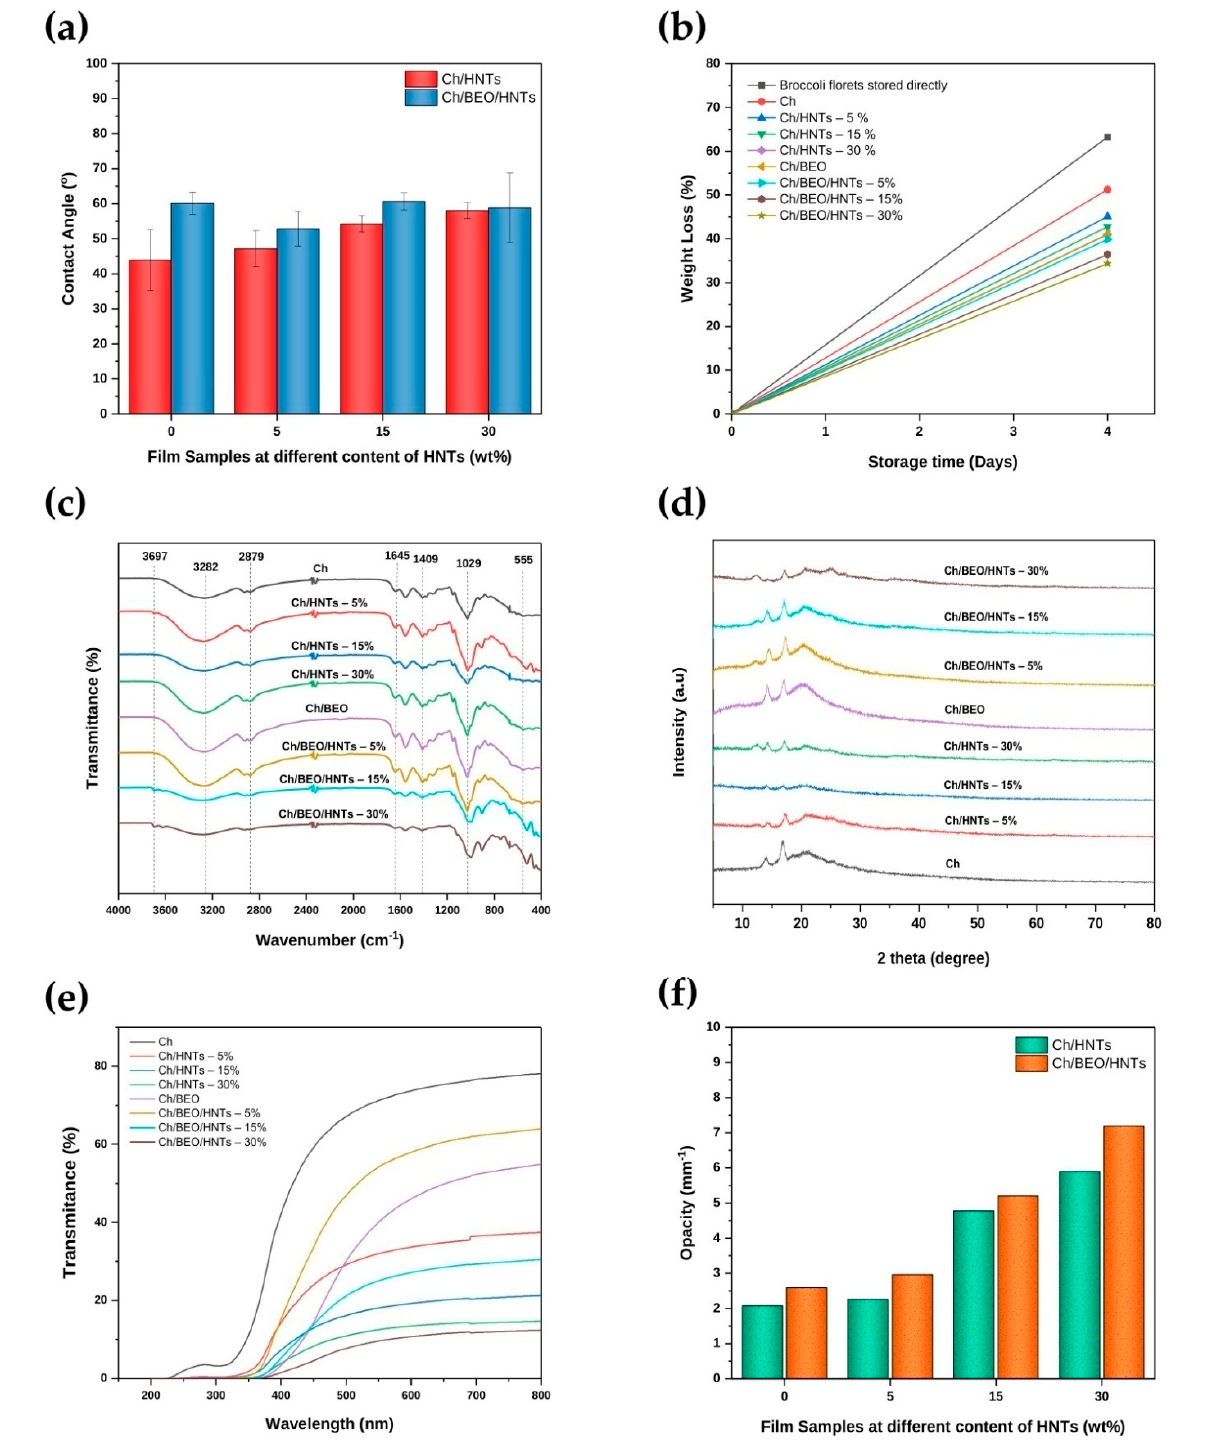
Figure 7. Figures representing the ( a ) contact angle of Ch films formulated with HNTs and BEO; ( b ) weight loss during 4 days storage; ( c ) ATR–FTIR spectrum of Ch films formulated with HNTs and BEO; ( d ) XRD pattern analysis of Ch films formulated with HNTs and BEO; ( e ) UV transmittance of Ch films formulated with HNTs and BEO; ( f ) opacity of Ch films formulated with HNTs and BEO.